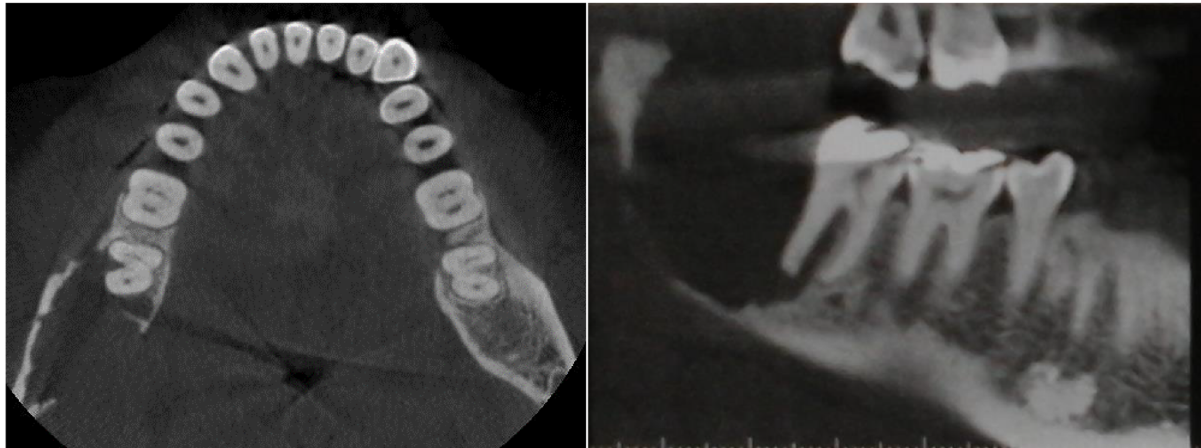
Fig. 4. Axial and coronal CBCT slides showing the tumour extension with